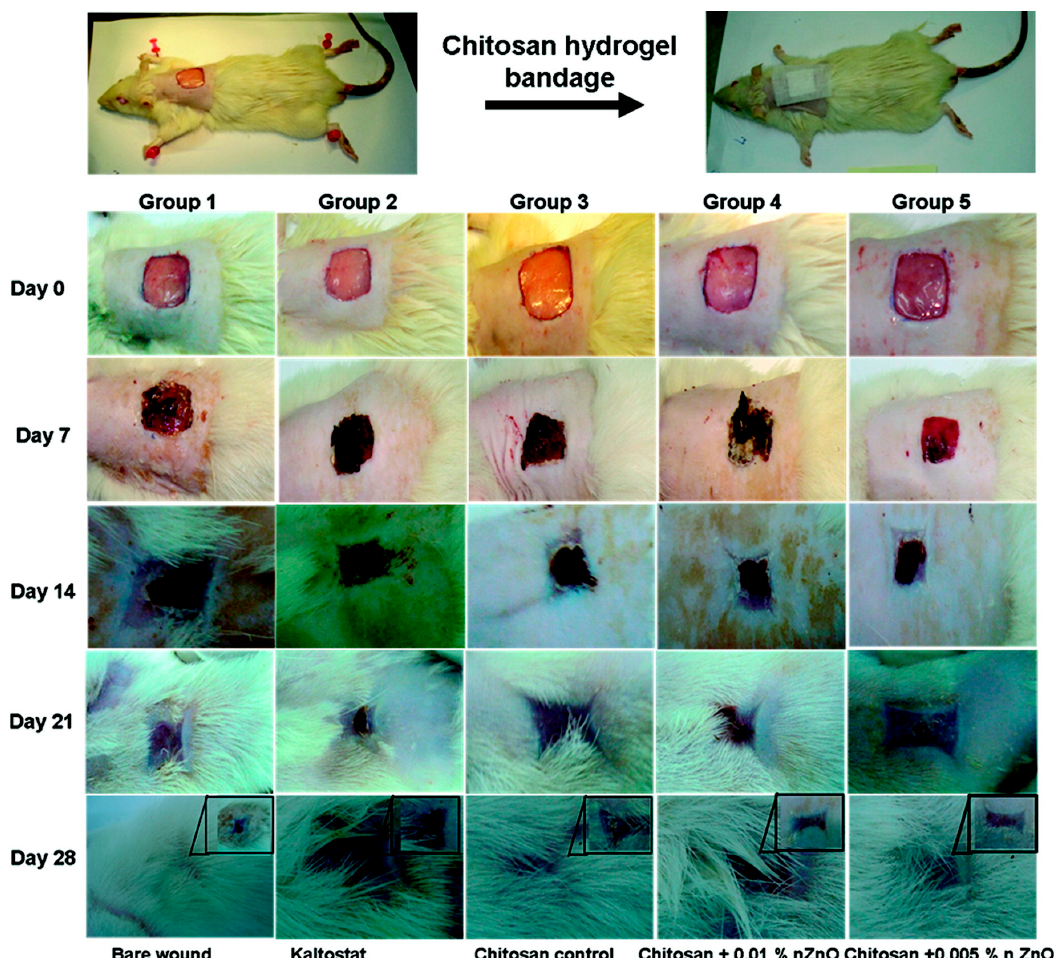
Figure 12. In vivo images of the wound healing process in Sprague − Dawley rats. Reproduced with permission from [125]. American Chemical Society,